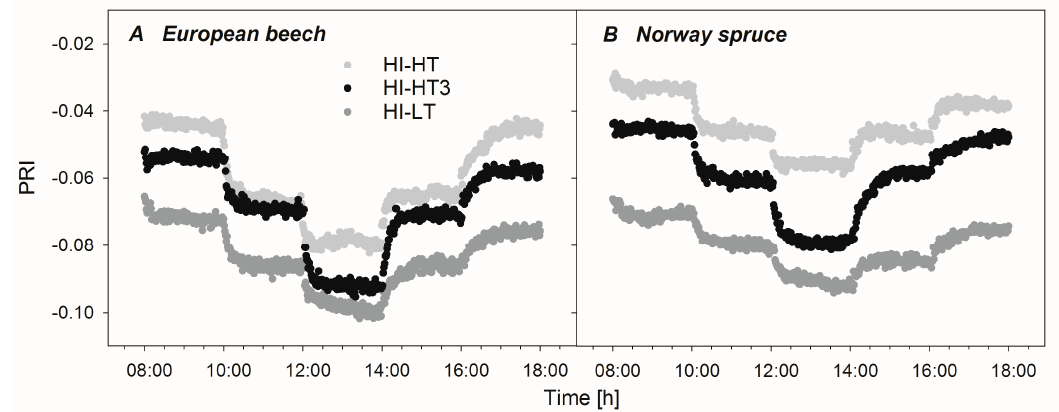
Figure 1. Examples of diurnal photochemical reflectance index (PRI) courses in European beech ( A ) and Norway spruce ( B ) saplings during regimes of high photosynthetically active radiation (PAR) intensity and high temperature (HI–HT), high PAR intensity and low temperature (HI–LT), and high PAR intensity and the highest of three different high temperature conditions (HI–HT3).